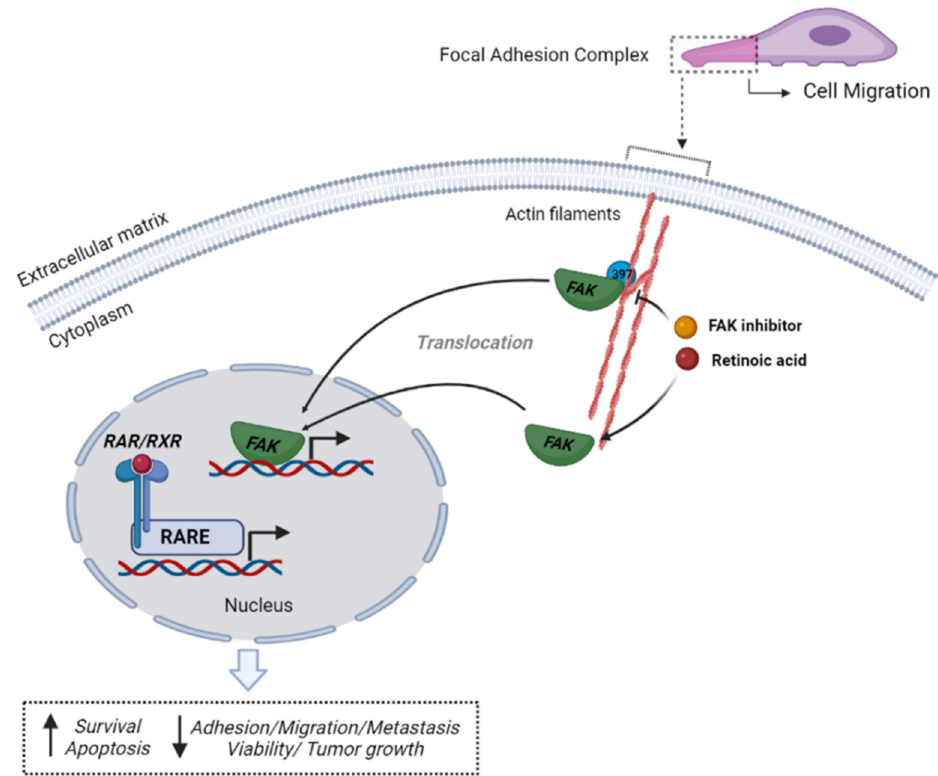
Figure 6. Schematic figure of molecular changes triggered by RA plus FAKi in BC. Retinoic acid (RA) and FAK inhibitor (FAKi) induces FAK translocation from focal adhesion sites and cytoplasm to the nucleus. In the nucleus, FAK acts as a transcription factor in a kinase-independent manner. In parallel, RA binds to receptors RXR/RARs regulating the transcription of target genes. As result, cell detachment occurs blocking cell migration and reducing the metastatic process. Likewise, cell viability diminished due to apoptosis induction decreasing tumor growth and increasing mice survival. Figure created by BioRender.